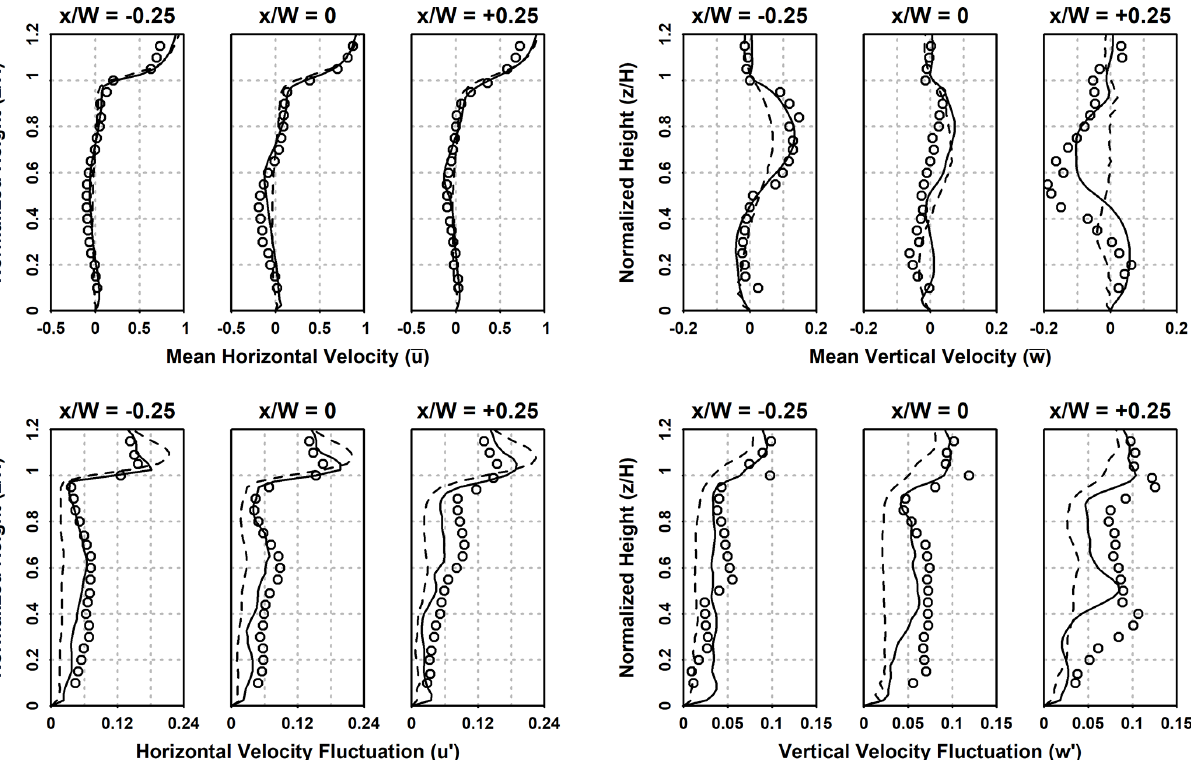
Figure 3. Normalized vertical profiles of the of resolved mean horizontal (top left) and vertical (top right) velocity components, as well as horizontal (bottom left) and vertical (bottom right) velocity fluctuations, for stations located at x/W = − 0 . 5 (left), 0 (middle), and + 0 . 5 (right) in the idealized street canyon geometry. Solid lines indicate the present study using fine mesh; dashed lines indicate the present study using coarse mesh; and symbols represent the LDA measurements from Li et al. (2008).